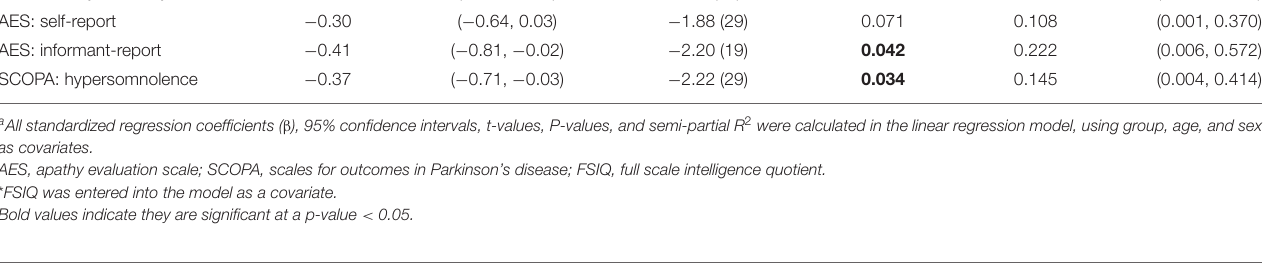
TABLE 5 | Disease duration as a predictor of clinical outcomes in DM1 a .